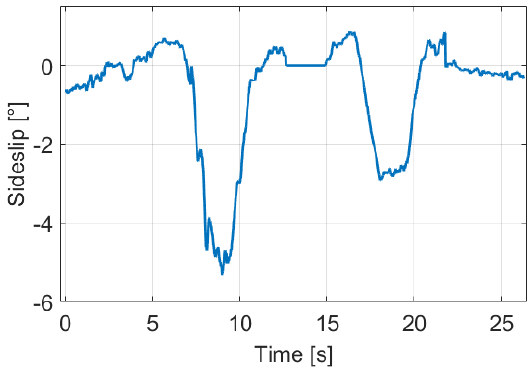
Figure 4. Sideslip signal of the motivation example.